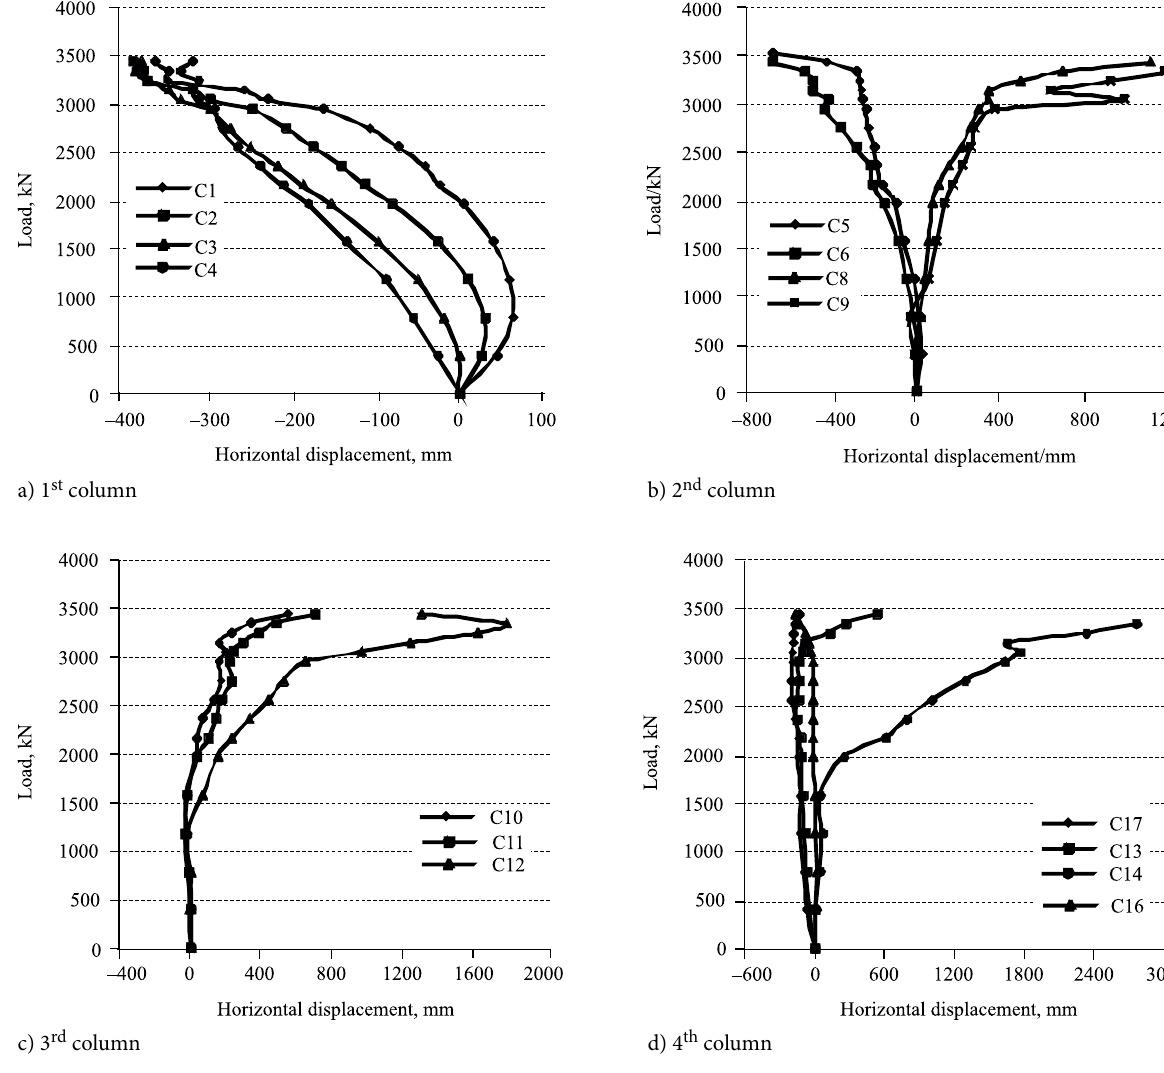
Fig. 11. Concrete strain test